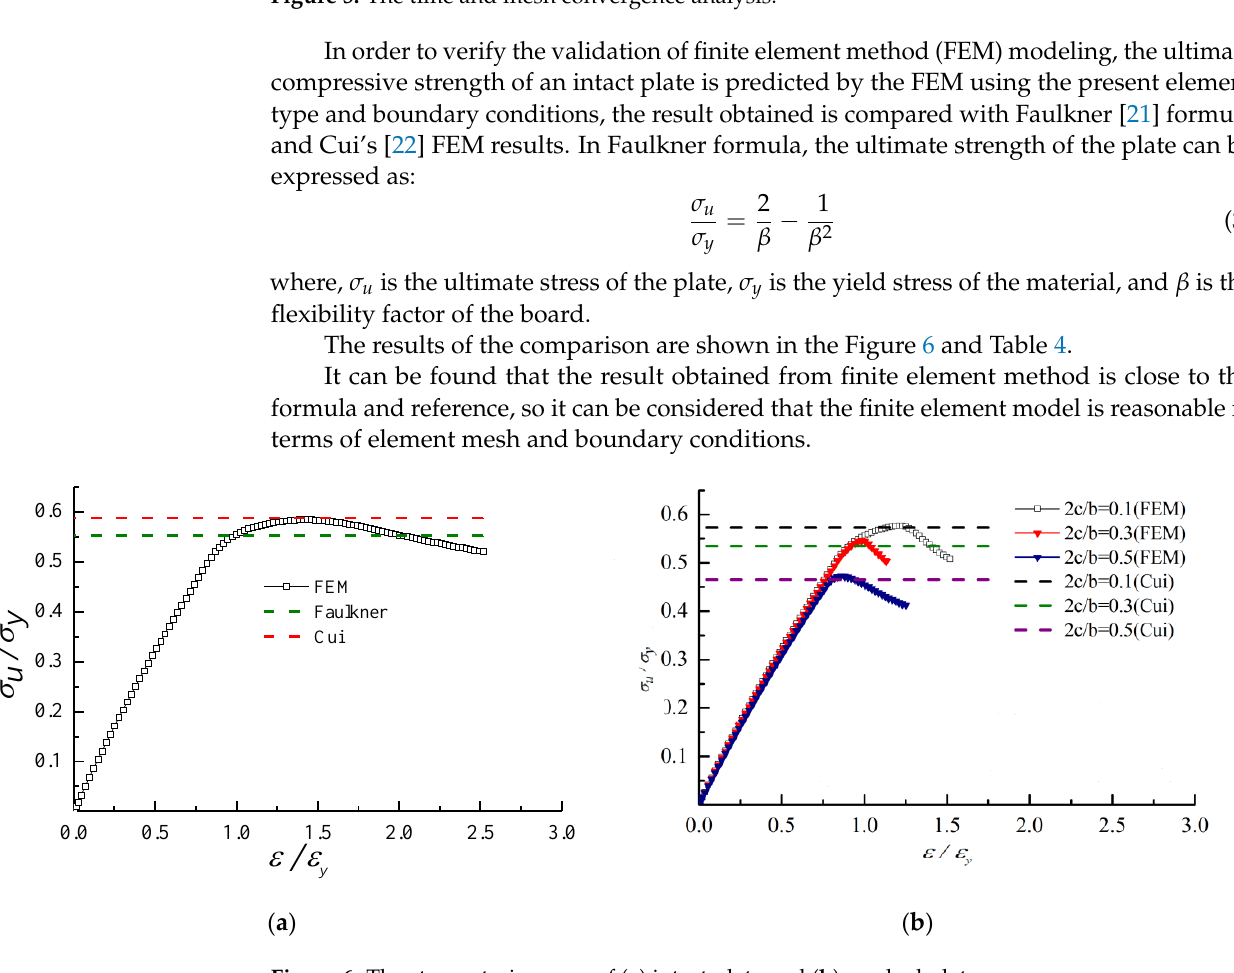
Figure 6. The stress-strain curve of ( a ) intact plate and ( b ) cracked plates.